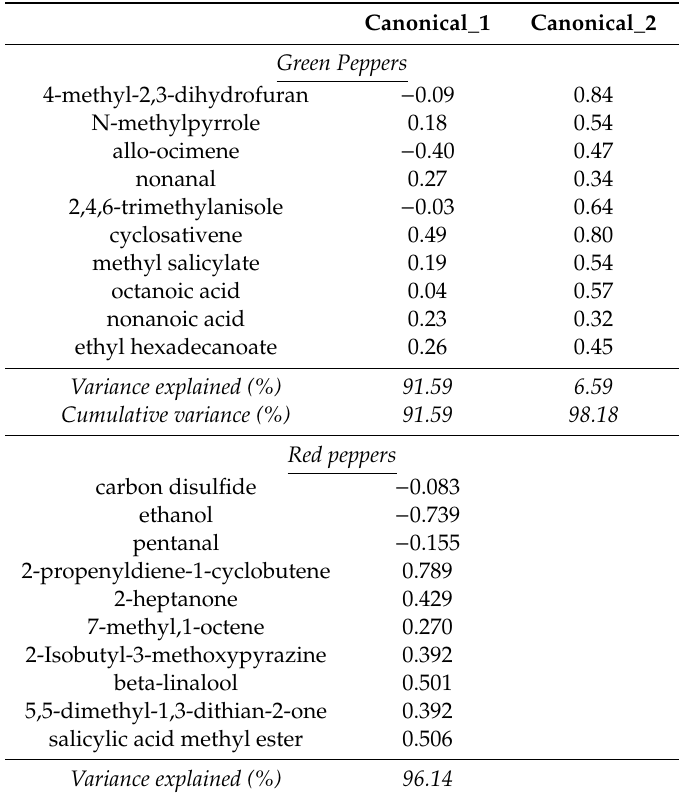
Table 5. Correlations between the total canonical structure and the original